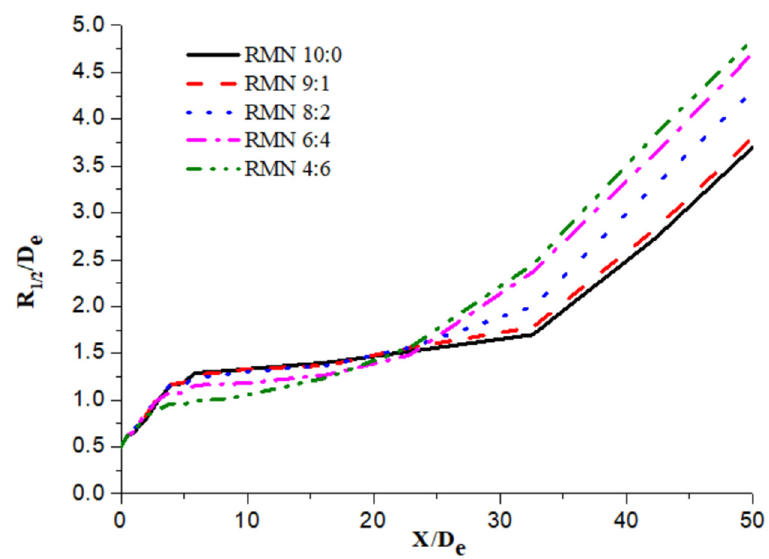
Figure 7. Half-jet width distribution for various jets.